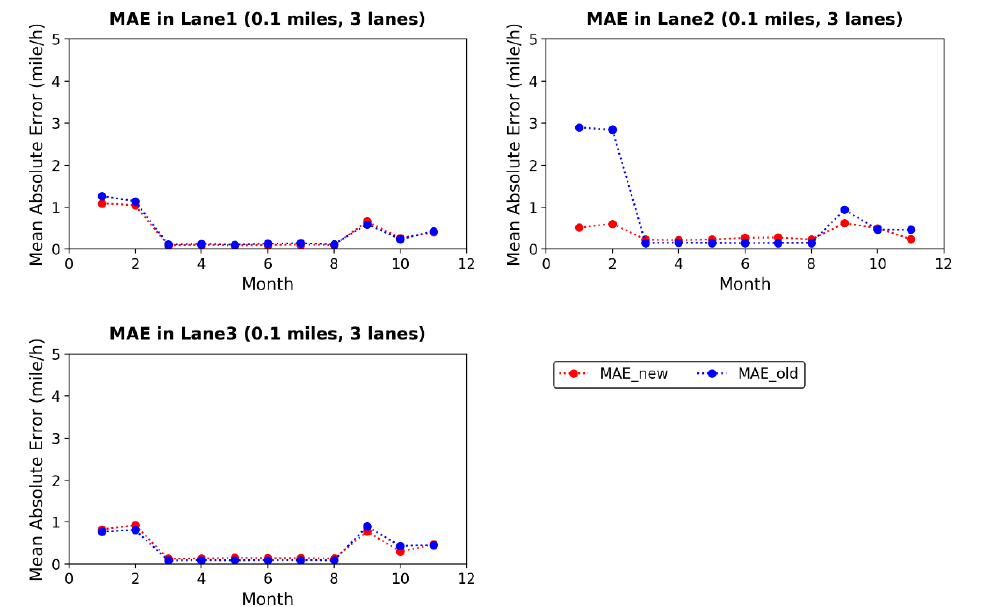
Figure 3. MAE curves of the new system and the old system in segment {0.1 miles, 3